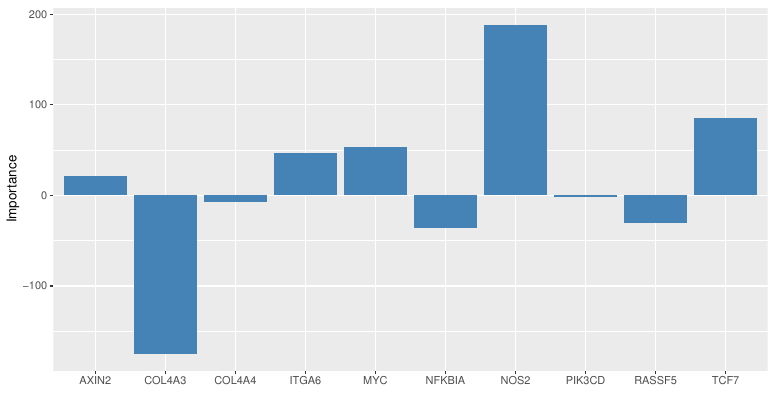
Figure 1. Variable importance according with the glmnet